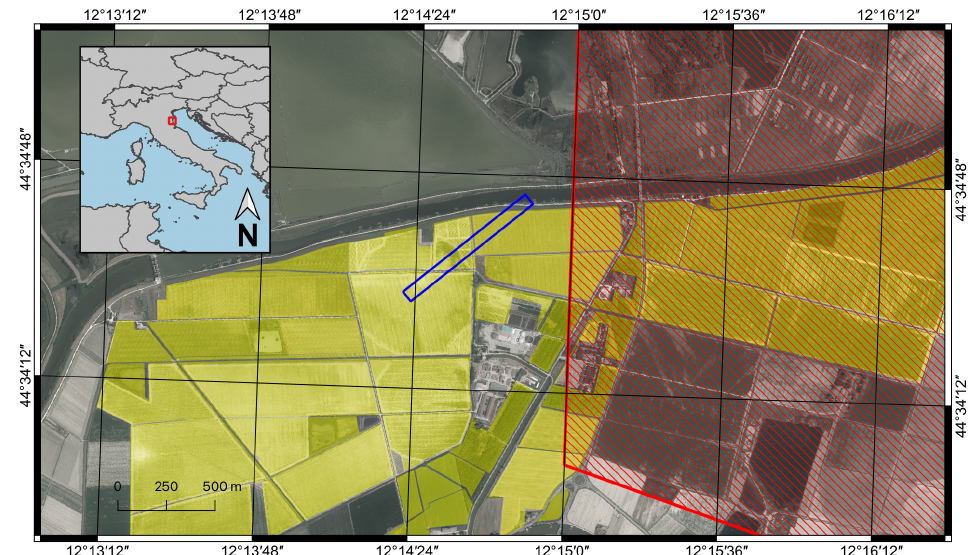
Figure 2. The location of the case study. The UAV corridor is delimited by the blue boundary. Polygons of the fields of Agrisfera are highlighted in yellow with NFZ highlighted in red. Orthophoto AGEA 2011 is provided by Regione Emilia-Romagna Geoportal and used as the